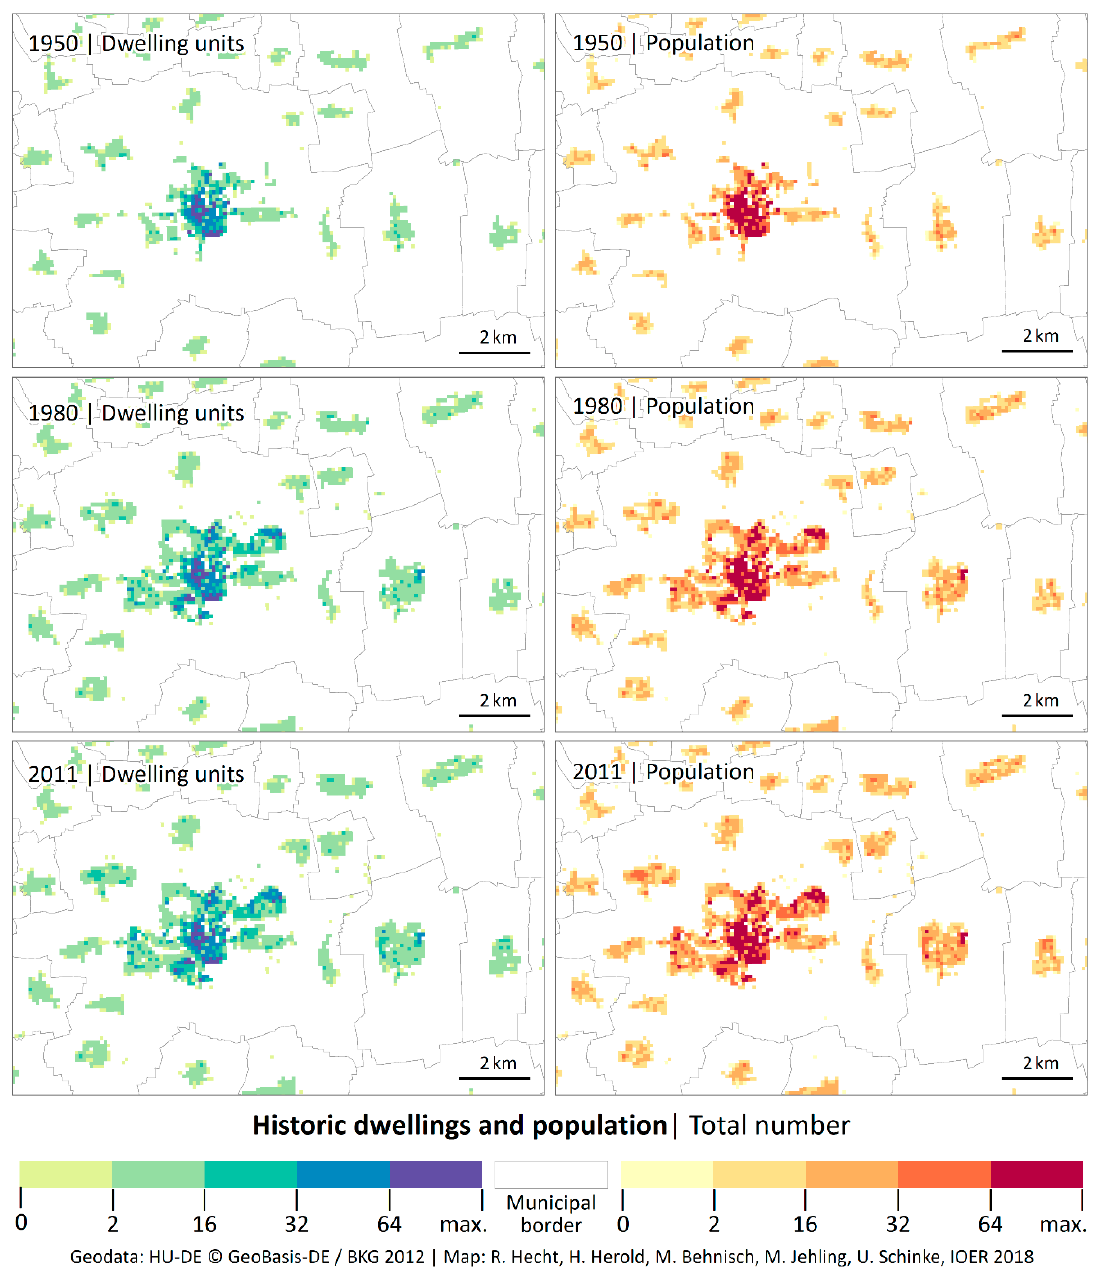
Figure A2. Historic dwellings and population for 1950, 1980 and 2011 at the level of 100 m grid cells.